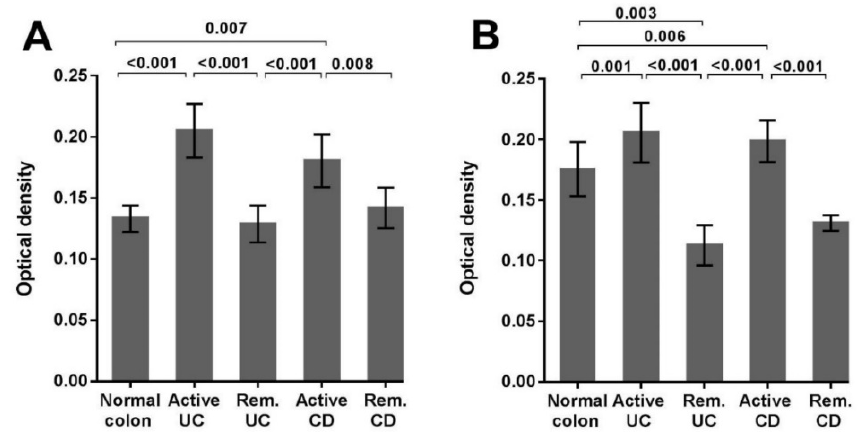
Figure 4. Quantification of NLRP3 and IL-1 β IHC staining in biopsies sections from normal and IBD patients. ( A ) Quantitative analysis of NLRP3 expression in sections from normal colon (total number